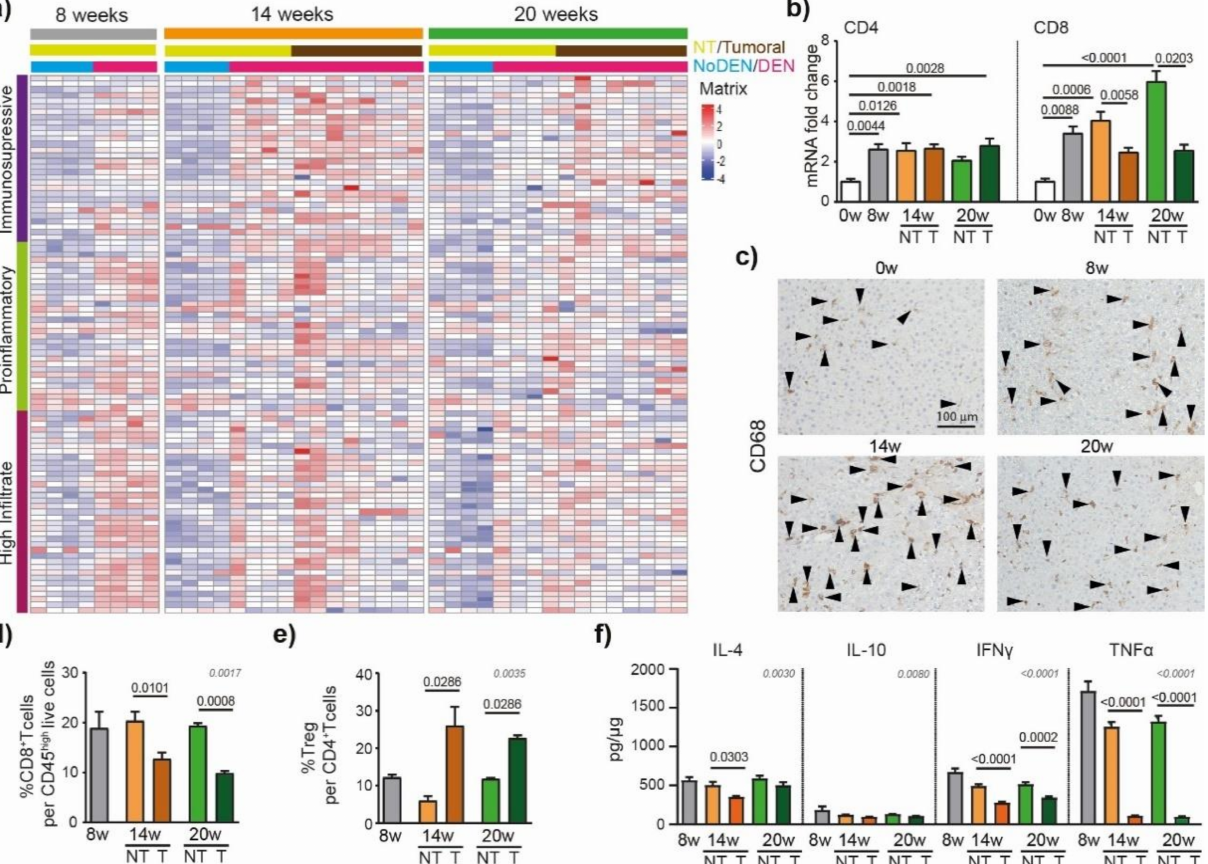
Figure 4. DEN induces modulations of the tumor’s immune microenvironment. ( a ) Heatmap showing the relative expression of genes from the immune-mediated cancer field (ICF) gene expression signature associated with the development of human HCC [22]. Subclasses are stratified based on lymphocyte infiltration and on the activation of either immunosuppressive or pro-inflammatory signals. ( b ) qPCR analysis of CD4 and CD8. The 0 w was set as 1, values are mean ± SE, n = 9/group. Comparison of means was performed by ANOVA test with Tukey correction; w = week. ( c ) Representative images of CD68 staining (20 × magnification-black arrows). ( d ) Frequency of CD8 + T cells per CD45 high live cells and ( e ) frequency of Treg (CD25 + Foxp3 + ) per CD4 + T cells in tumoral and non-tumoral liver tissues at 8 w, 14 w and 20 w measured by flow cytometry analysis; values are mean ± SE, n = 9/group. ( f ) Interleukin-4 (IL-4), interleukin-10 (IL-10) interferon gamma (INF- γ ) and tumor necrosis factor alpha (TNF- α ) protein concentration in tumoral and non-tumoral liver tissue at 8 w, 14 w and 20 w measured by Elisa; values are mean ± SE, n = 13/group. ( d – f ) significant p -values (in black) show the comparison between tumoral and non-tumoral values at 14 w and 20 w obtained by Mann–Whitney testing. Comparisons of all the means were performed using the ANOVA test with Tukey correctio; p -values in